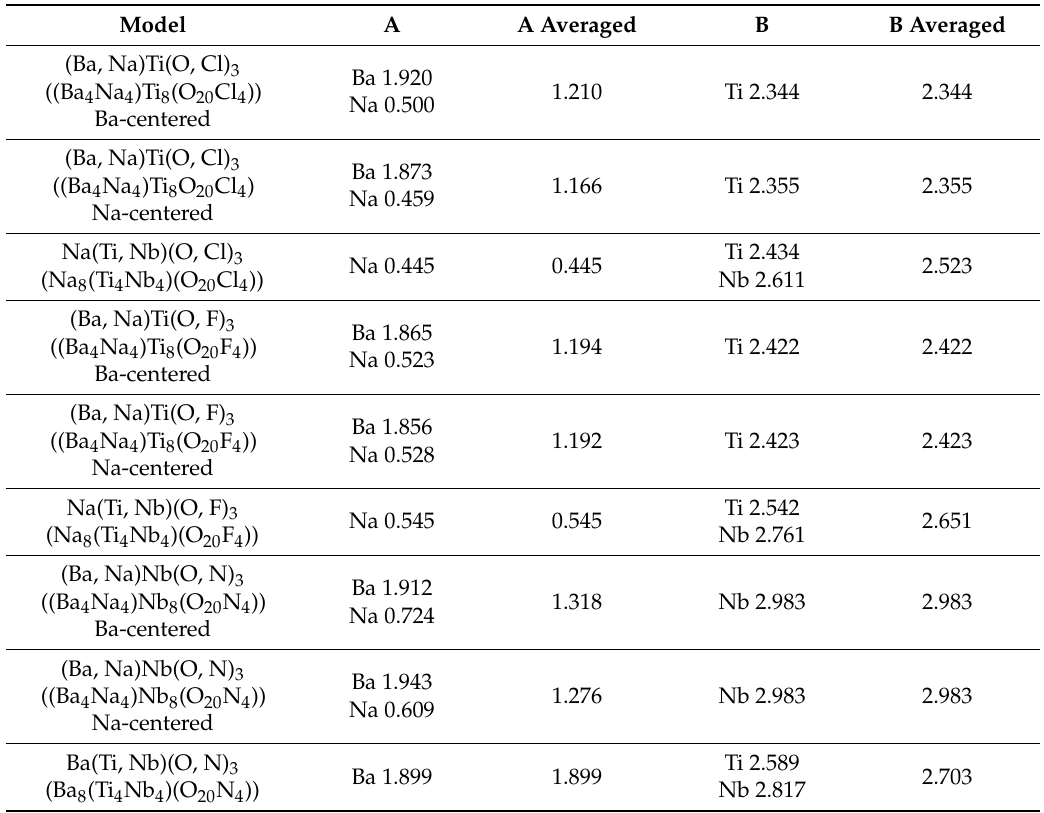
Figure 9. Map of the values in Table 8. The dots of PT and (Ba, Na)(Ti, Nb)O 3 in Figure 7 are given for comparison. Table 8. E ff ective charges of solid solution models (Ba, Na)(Ti, Nb)O 3 ; O ions were partially replaced with halogen Cl or F, or not halogen N. Each of the detailed chemical notations of the models is given in parenthesis in each cell on the